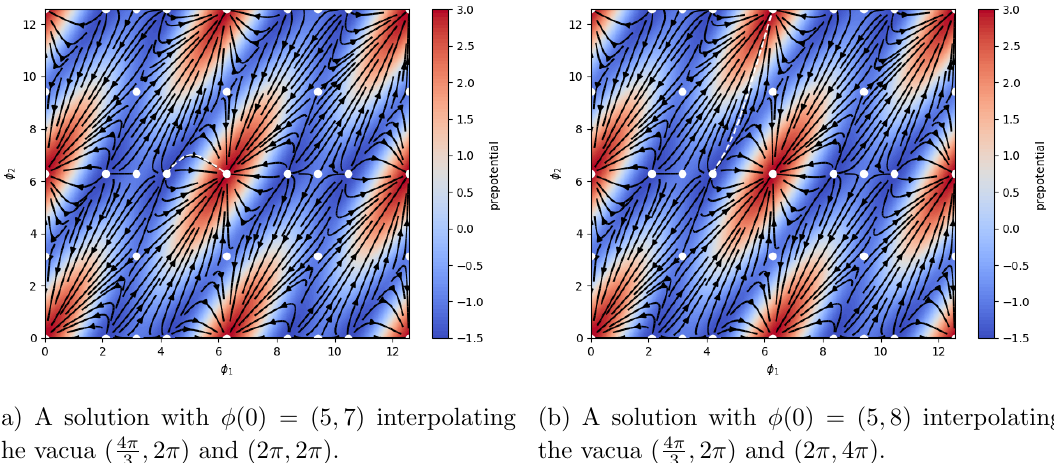
Figure 5. The r (cid:17) W lines are plotted as black arrows over the prepotential W . The paths described by the solutions in (cid:12)gure 2 are plotted as white dashed lines connecting the vacua which are the white dots.